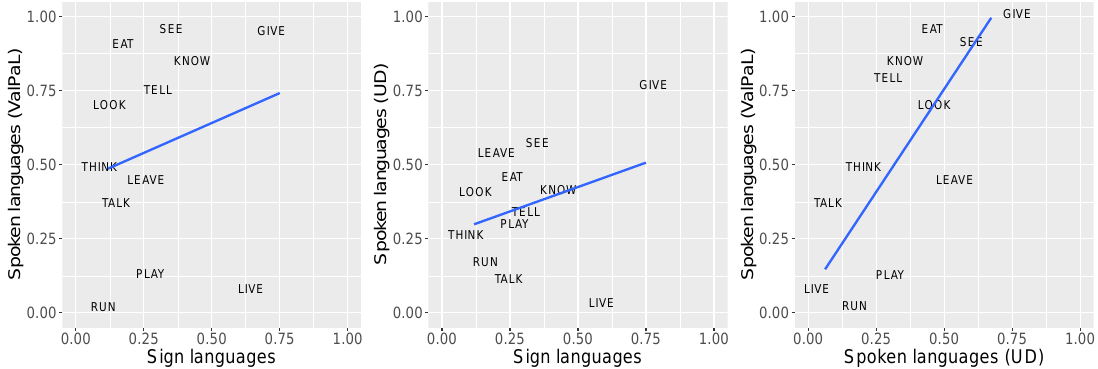
Figure 7: The transitivity proportion of the 12 ValPaL meanings compared for each of the three language group pairings: SL– ValPaL (left); SL–UD (middle); and ValPaL–UD (right). The blue lines show a fitted linear regression for each pairing.